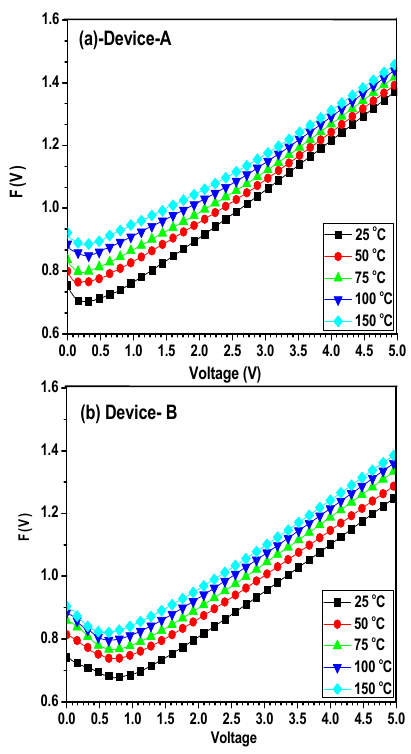
Figure 7. The F ( V ) versus V plot for ( a ) device-A and ( b ) device-B tested in the temperature range of 25 to 150 °C.